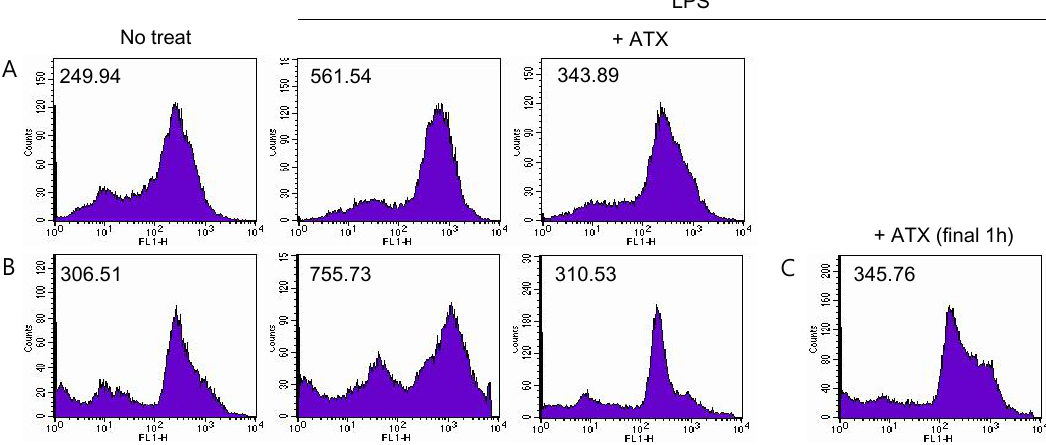
Figure 4. ATX treatment reduces ROS level in MDSCs. MDSCs were isolated from spleens of tumor-bearing mice and cultured for ( A ) 24 h and ( B ) 5 days in the presence of ATX and LPS. ( C ) MDSCs were incubated in LPS containing media for 5 d. At day 5, ATX was added to MDSCs, and then cells were incubated for 1 h. To measure the ROS level in MDSCs, we added CM-H 2 DCFDA to MDSCs and evaluated their fluorescence by flow cytometry. MFIs are shown. Data are representative of two independent